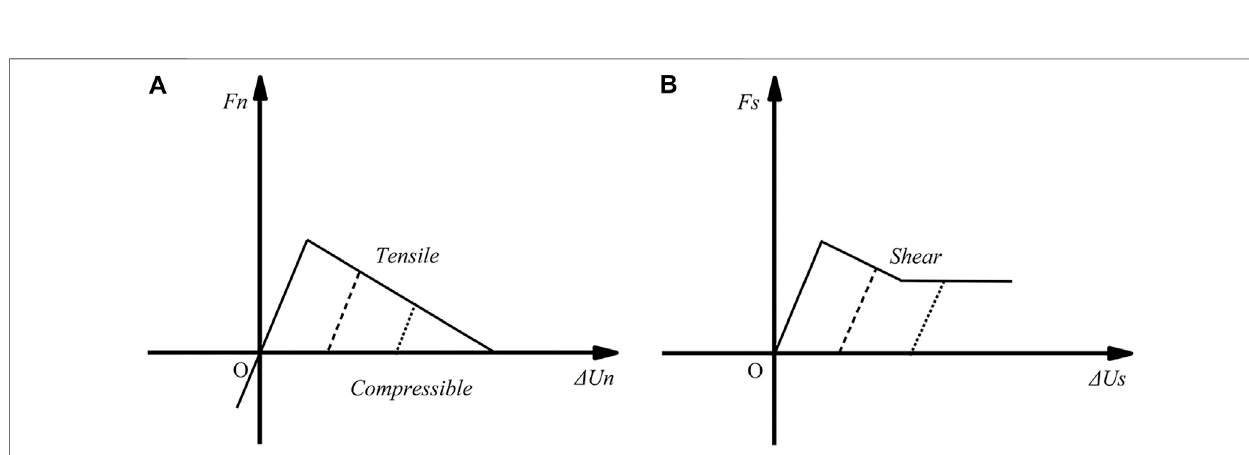
FIGURE3| Relationshipbetweenthebondingstressandopeningslidingdisplacement (A) undercompressionandtensionconditions; (B) undershearandsliding conditions.